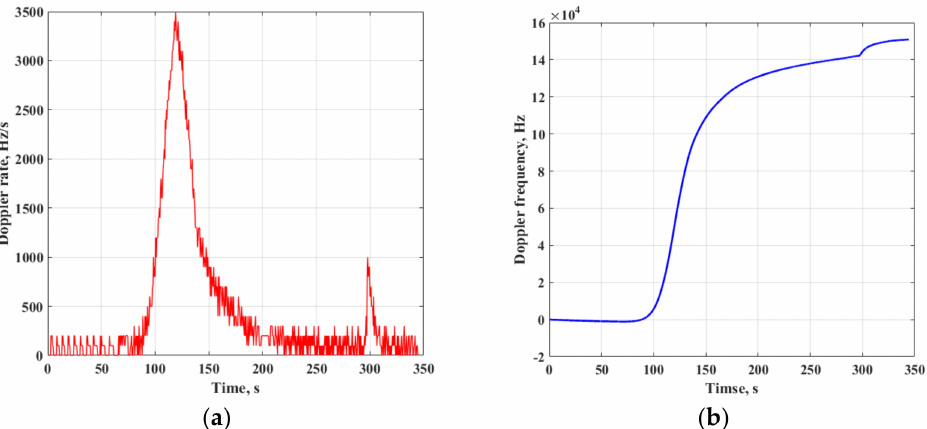
Figure 26. Estimation result of a 2D search approach for one entry, descent, and landing (EDL) flight